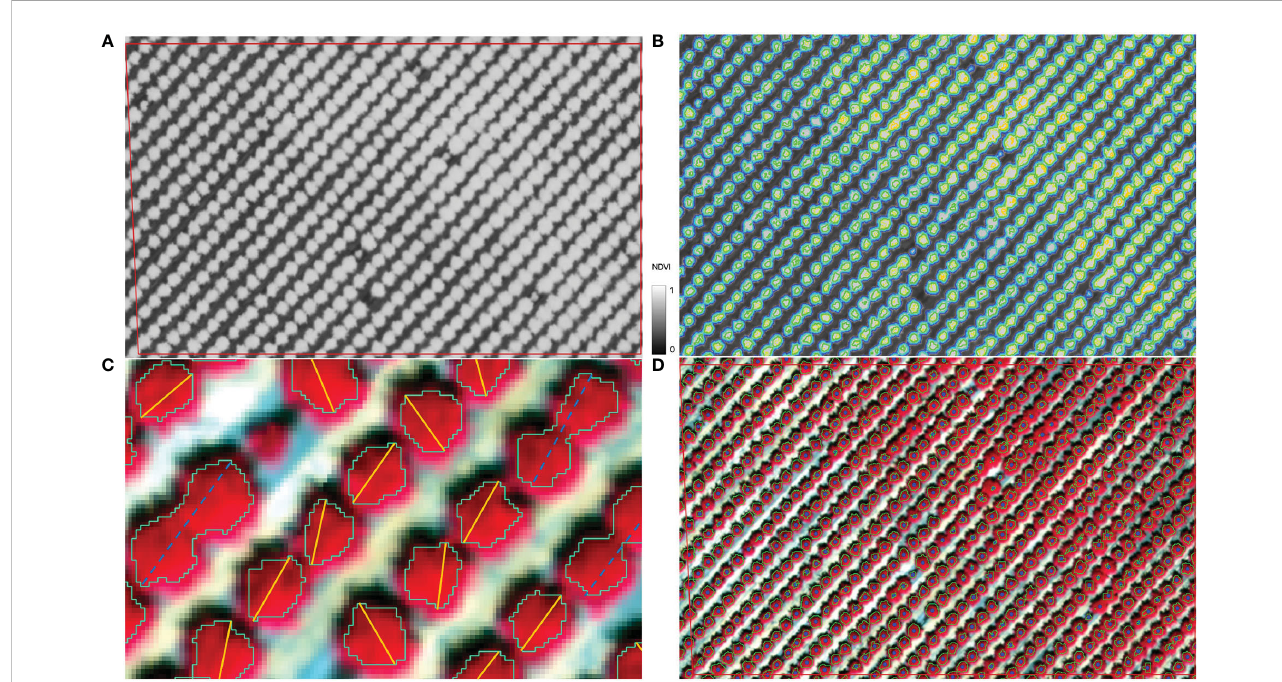
FIGURE 2 Illustration of individual tree identi fi cation work fl ow: (A) . NDVI map from CERES imagery; (B) . Segmented tree crowns with various NDVI threshold values, e.g., the blue polygon represents the boundaries from the segmentation with a NDVI threshold of 0.6; (C) . For each polygon layer identi fi ed using a particular NDVI threshold, remove those crown polygons whose major axis (dashed blue line) were longer than the expected maximum tree crown diameter, roughly the tree planting spacing along the orchard row; (D) . Final tree crowns by combining all layers of potential crown polygons and center locations of all individual